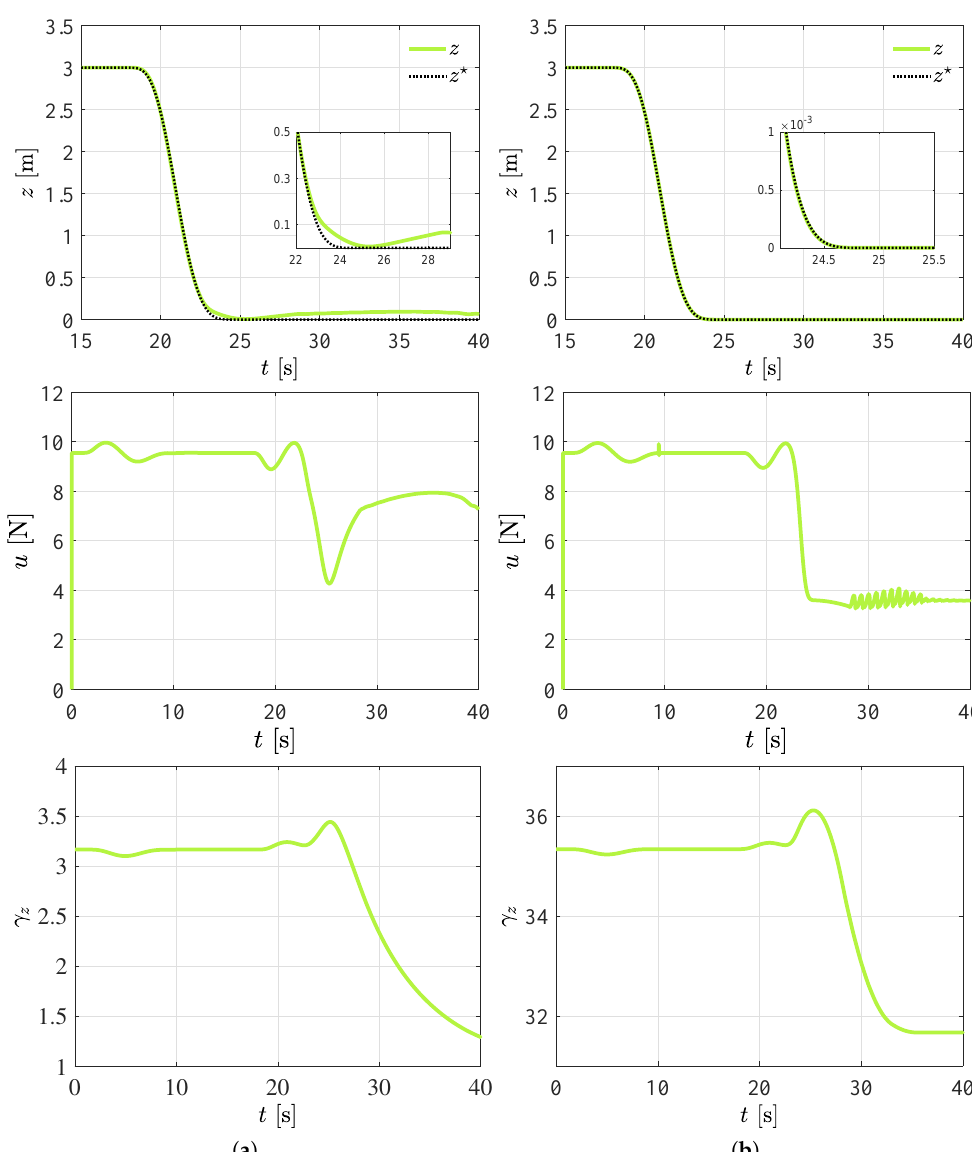
Figure 10. Quadrotor autonomous landing under the ground effect phenomenon: ( a ) First case. ( b ) Second case.